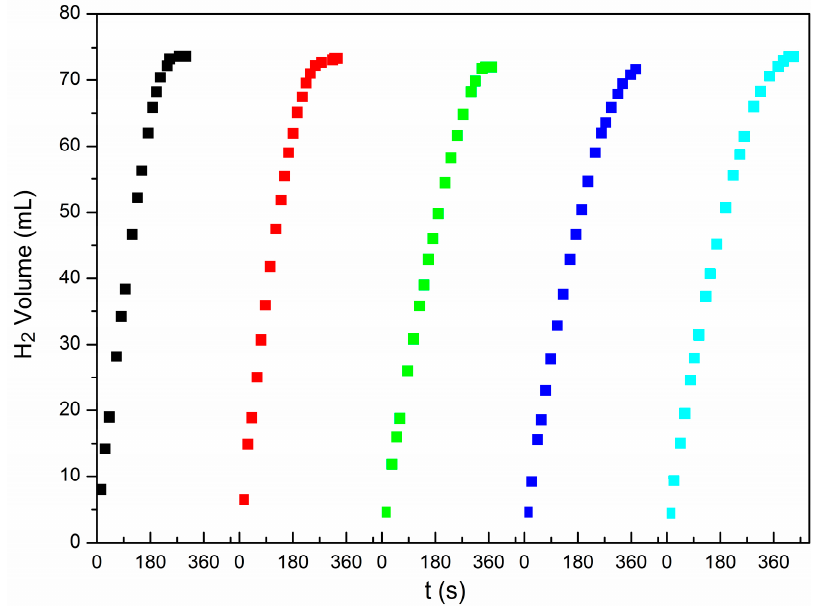
Figure 8. The stability test of Cu@Pd 0.5 / C -320.